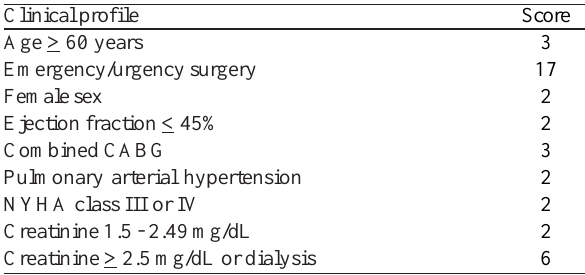
Table 1. Factors associated with development of outcome (death) after heart valve surgery and appropriate score